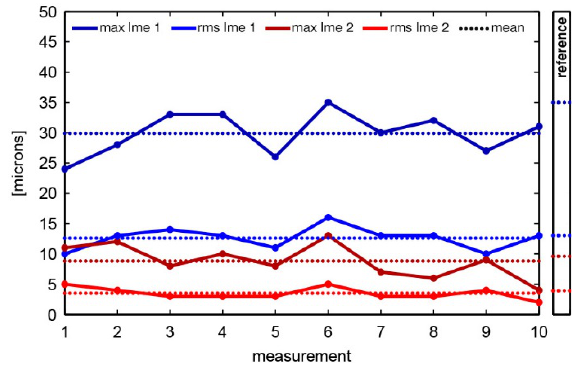
Figure 9. Quality characteristics (systematic pattern correction) The LME MAX 1 has decreased by 14 % to 30 µm in mean value.